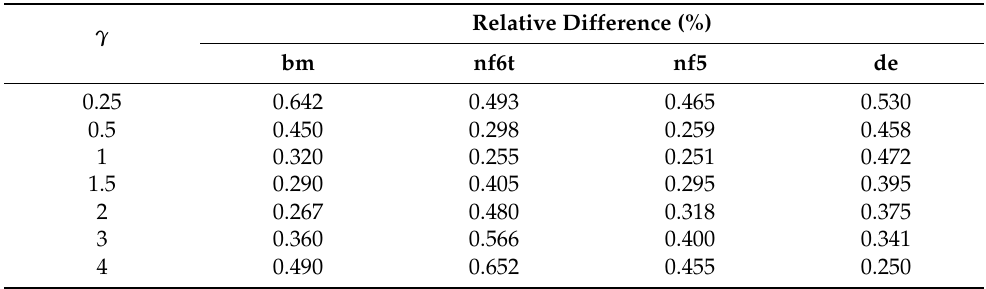
Table 5. Relative differences of the bm , de , nf5 , and nf6t relaxation schemes from an ε -global optimal solution with partition size